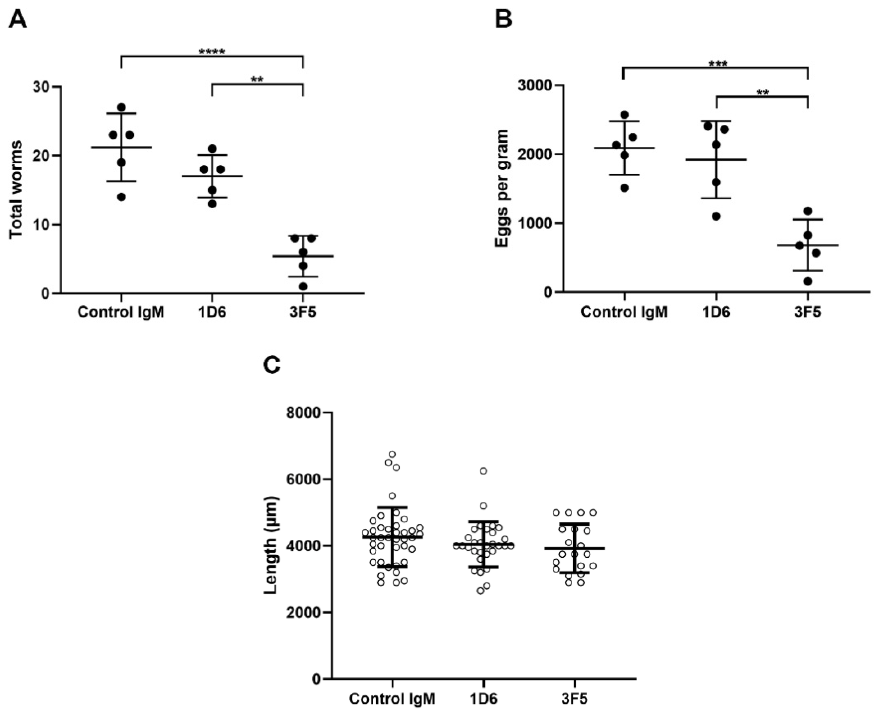
Figure 4. ( A ) Hamsters immunized with 3F5 harbored significantly fewer worms and ( B ) passed significantly fewer fecal eggs than hamsters immunized with 1D6 or isotype control mAb. ( C ) The average lengths of liver flukes recovered from hamsters that were immunized with 1D6 and 3F5 showed a trend towards stunting (4.0 ± 0.68 mm and 3.9 ± 0.73 mm, respectively) when compared to the isotype control group (4.29 ± 0.89 mm), but the differences did not reach significance ( p = 0.48 and p = 0.26, respectively). ** p < 0.01, *** p < 0.001, and **** p < 0.0001.